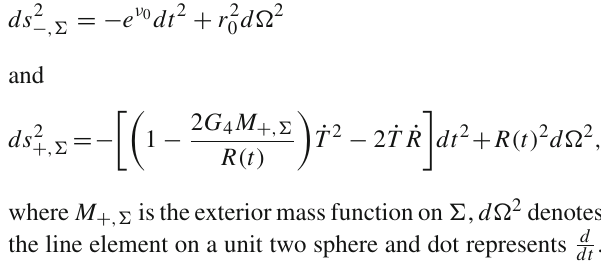
Fig. 1 2 G 4 M and G 4 r 2 figure), corresponding contour plot (right